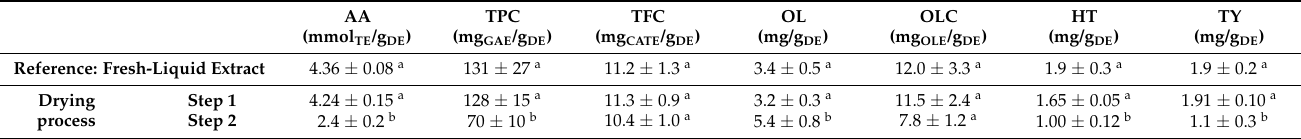
Table 3. Effect of extract drying on the retention of the responses measured, compared to a freshly obtained liquid extract (reference: conventional phenolic extract produced using freeze-dried olive pomace (OP)). Step 1 included only ethanol (EtOH) evaporation (extract in liquid state), followed by step 2: freeze-drying of the extract (extract in solid-state). Values with different lowercase letters in the same column are significantly different ( p <